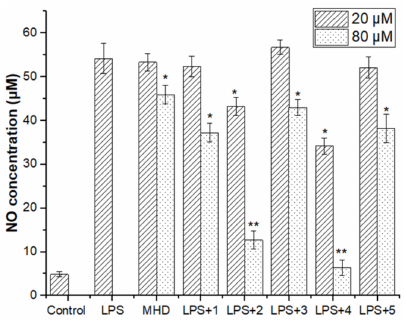
Figure 3. The effect of 1-methylhydantoin cinnamic imides on the release of NO from RAW264.7 cells induced by LPS. (n = 3, * p < 0.05, ** p < 0.01 vs. the LPS-treated